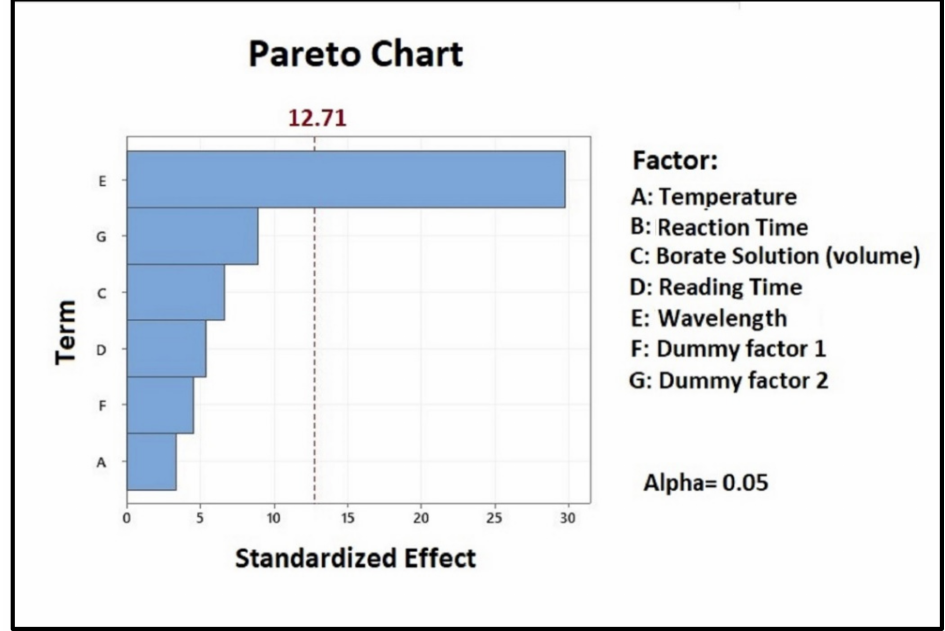
Figure 1. Pareto chart showing the effect of each variable examined during the assay set-up. In order to estimate the p -values of each component, all raw data obtained during the enzymatic activity set-up were subjected to multiple linear regression analysis. In the linear regression coefficient determination, the adjusted R 2 of 99.35% indicated that the model equation, given in uncoded units, was significant and could explain 99.35% of the variability in the response data. The equation revealed that all coefficients had a negative sign, so all factors showed a negative effect on the enzymatic assay. Furthermore, as already revealed by the Pareto chart, the only significant variable was the wavelength ( p = 0.02). All the other factors were not statistically significant ( p -value > 0.05